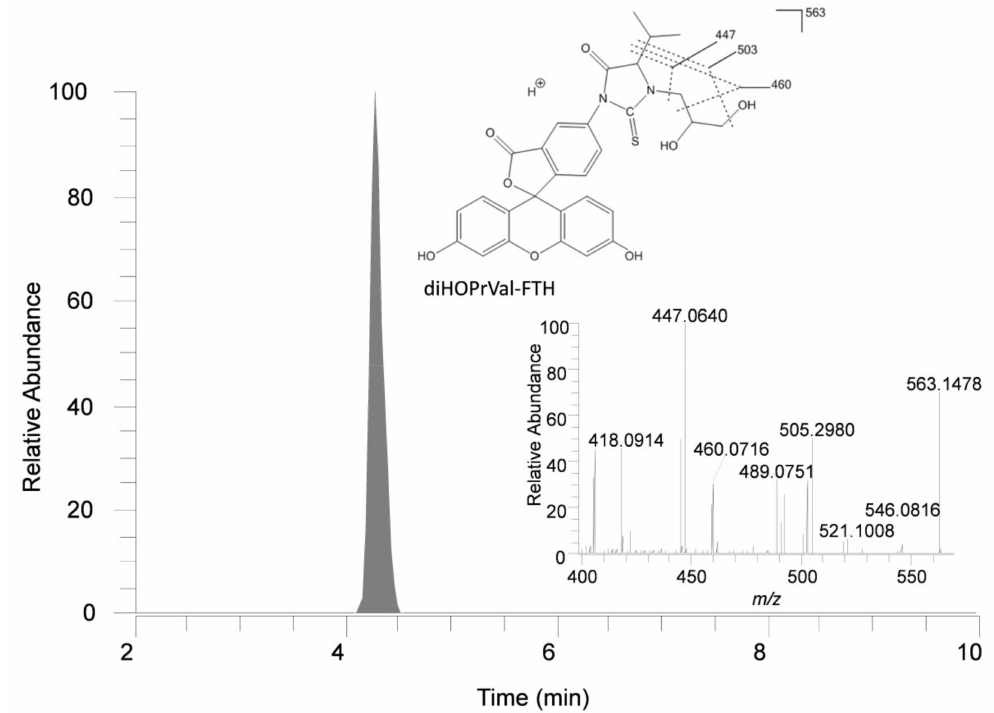
Figure 2. Ion chromatogram from a human sample and exact mass spectrum for the fluorescein thiohydantoin (FTH) derivative (diHOPrVal-FTH) of the N-terminal valine adduct formed by glycidol (6.6 pmol/g Hb at 3 ppm mass tolerance). The m/z fragments 503, 460 and 447 were used for quantification of the adduct diHOPrVal-FTH ( m/z